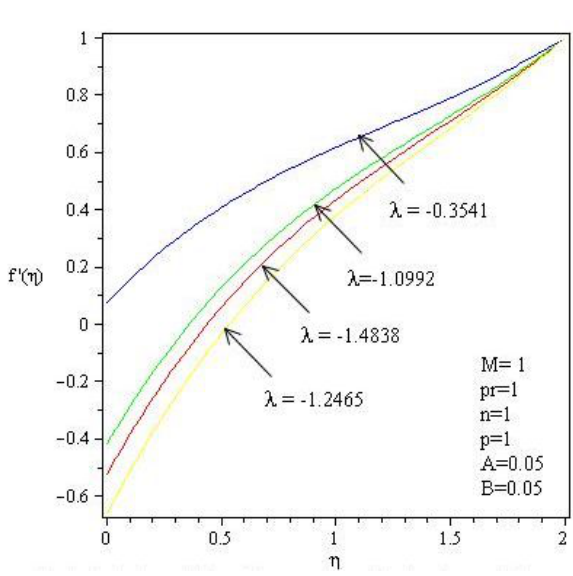
Fig. 7: Velocity profile for different values of λ when β = σ = 0.5